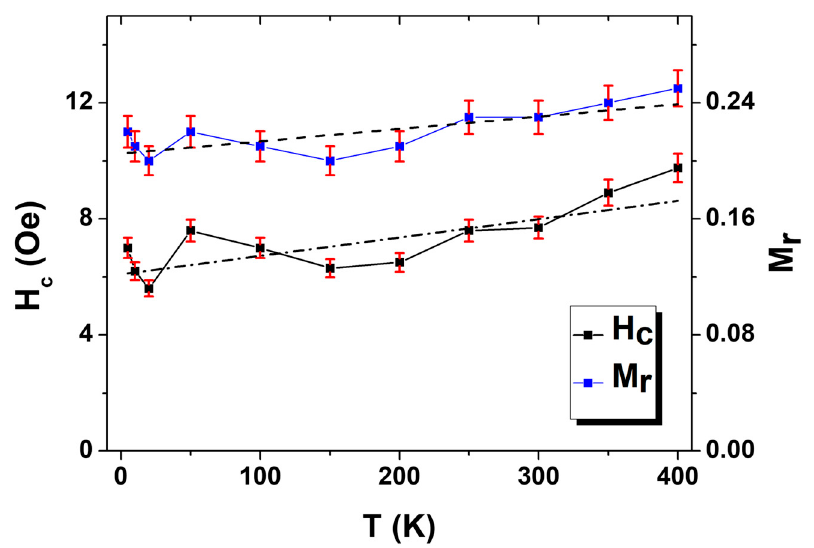
Figure 6. Temperature dependencies of coercivity (H c ) and normalized remanence (M r ) of as-prepared Co 2 MnSi glass-coated microwires. (Dashed lines indicates the liner fitting).